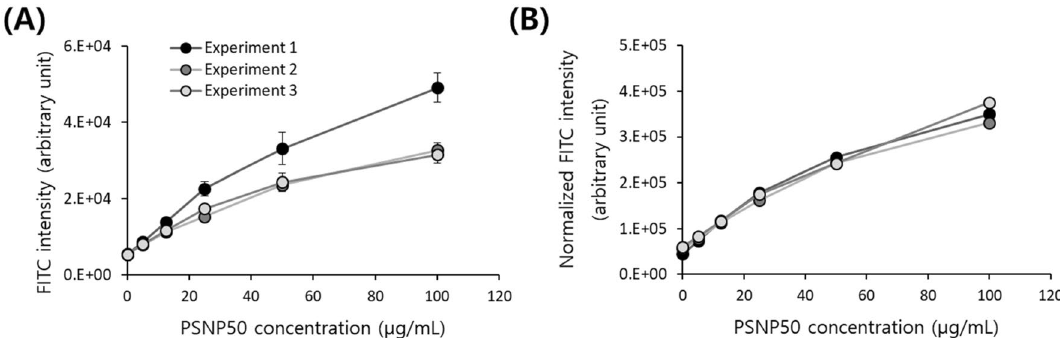
Figure 4. Quantification of nanoparticle uptake by Jurkat cells in multiple experiments. The scatter plots show three different sets of experiments with Jurkat cells treated with different concentrations of PSNP50. ( A ) Before and ( B ) after the normalization of FITC intensity with absorbance at 600